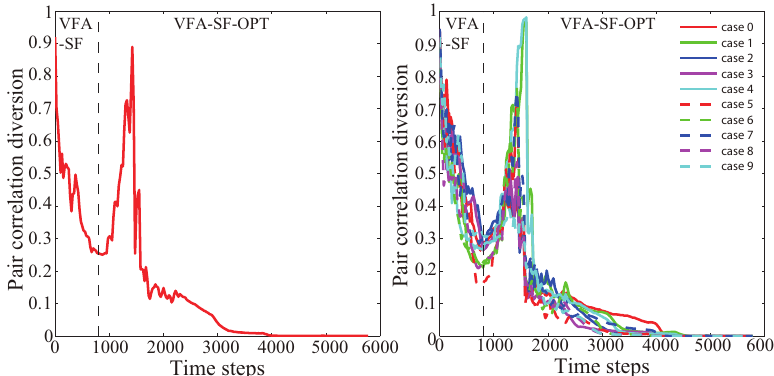
Figure 8. The variation of pair correlation diversion corresponding to the case in Figure 7. The dashed line indicates the 800th time step of VFA-SF.